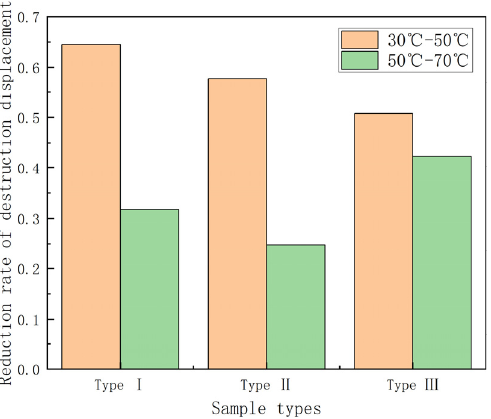
Figure 12. Destruction displacement reduction rate–temperature increment histogram.